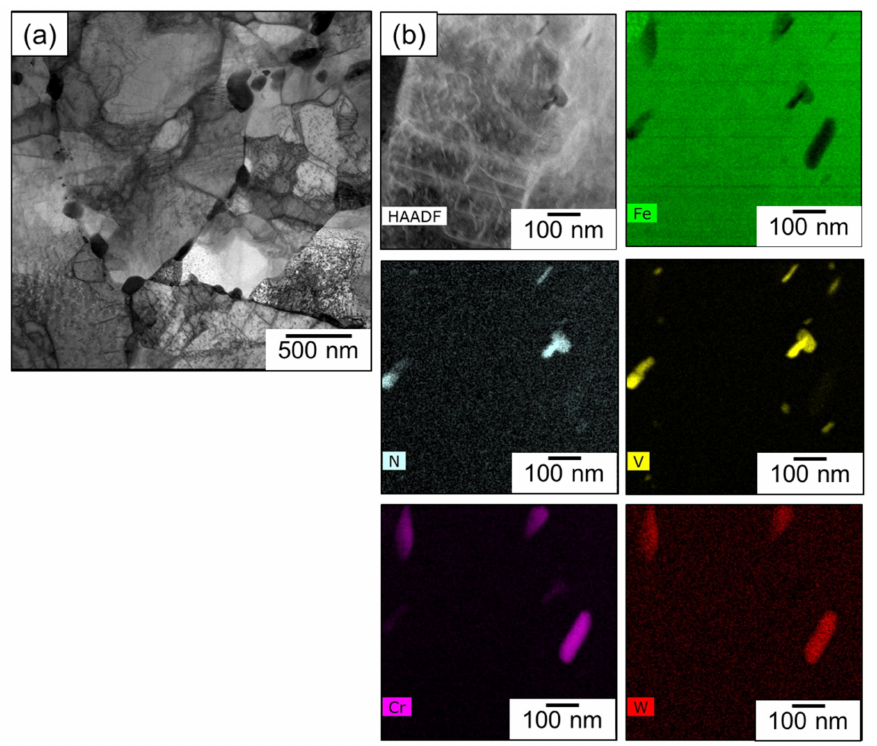
Figure 12. HAADF image of the microstructure after HT-2 ( a ). STEM EDS micrographs of area ( b ) are